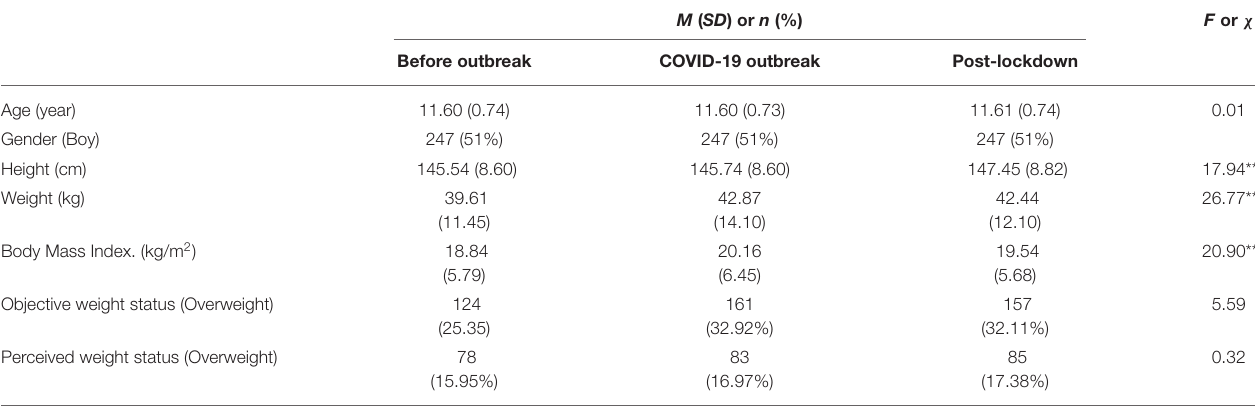
TABLE 1 | Characteristics of participants ( N =